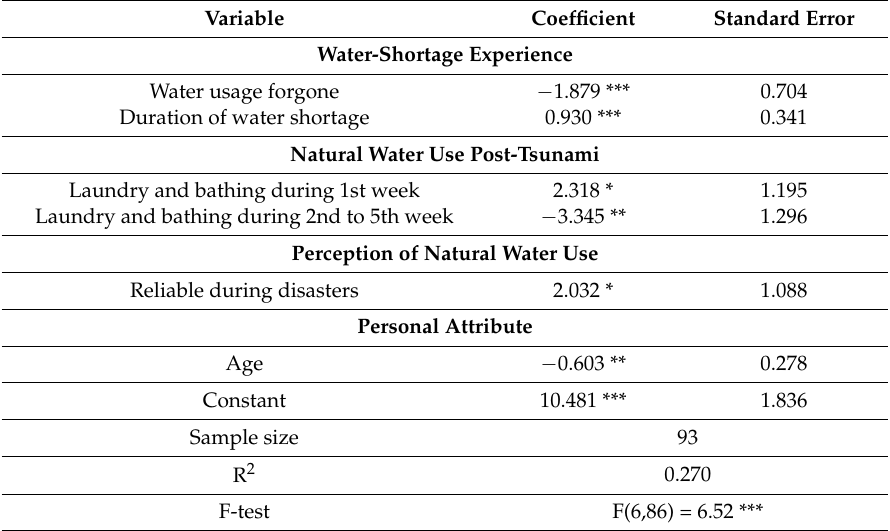
Table 6. Regression of individual parameters on explanatory variables